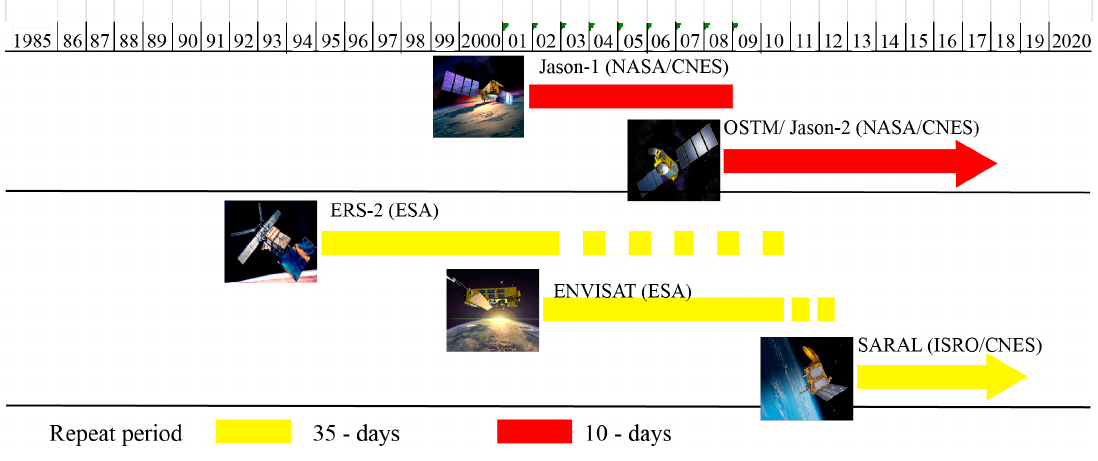
Figure 1. Timeline for radar altimeters used in our study (modified from [25]).